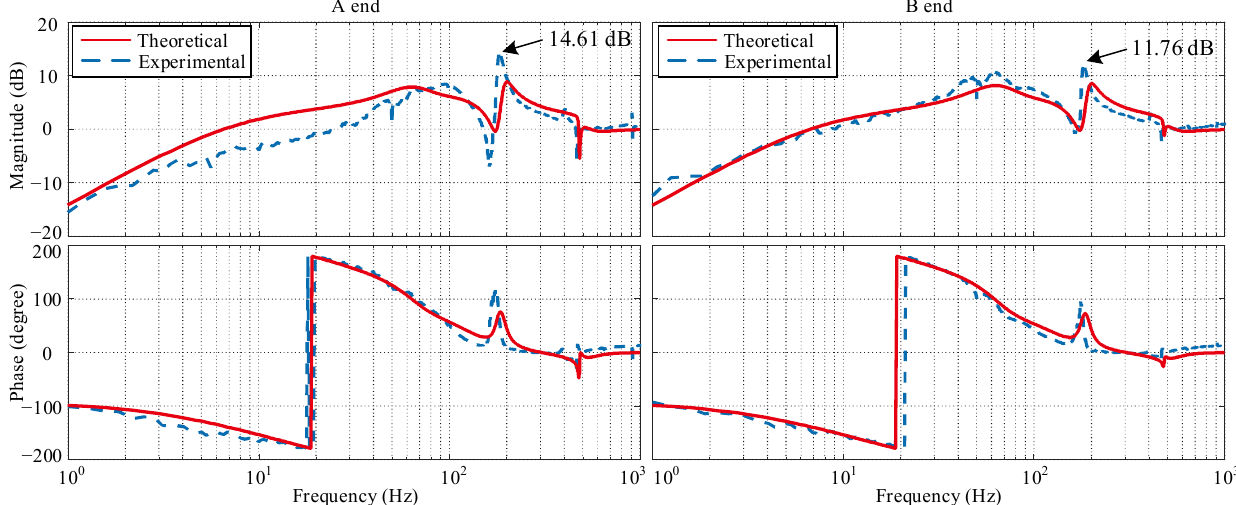
Figure 14. Sensitivity function comparison with the PID controller.